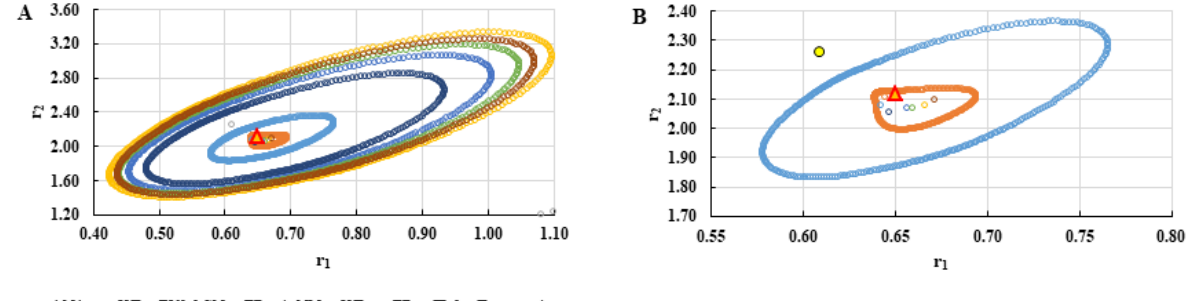
Figure 11. The JCR of analyzed methods for reactivity ratios calculation for LC2 imposed condition.